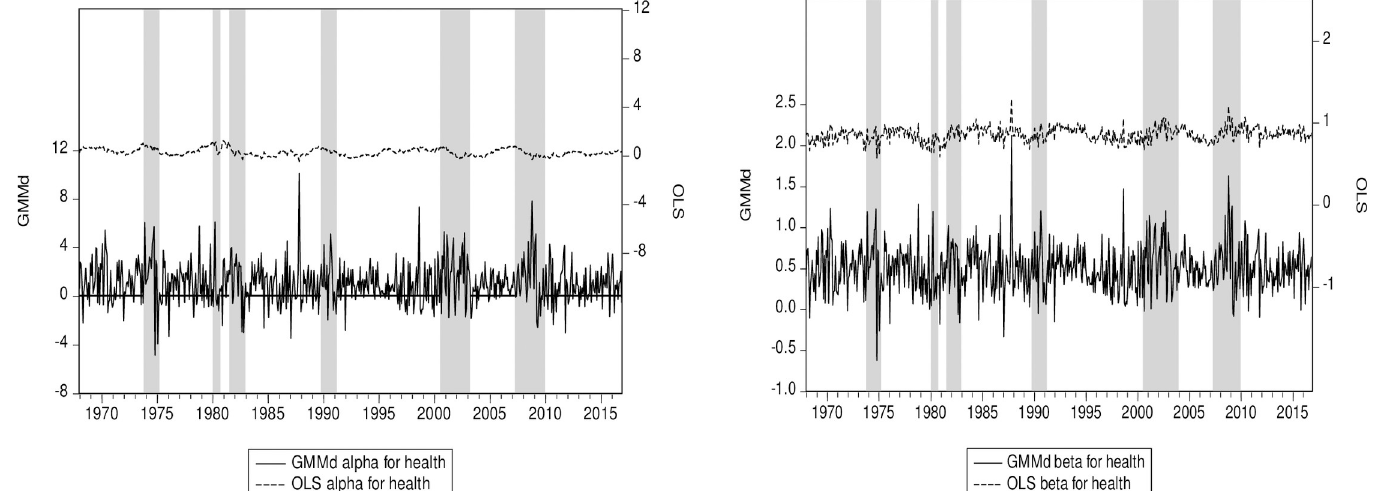
Fig 5. (a) Health alpha for RIV GMM and OLS. (b) Health beta for RIV GMM and OLS. Notes: The health sector has the lowest value of the OLS factor loading for illiquidity IML . RIV GMM (GMMd) is our robust instrumental variables approach. Shaded areas represent US recessions or crises. The OLS and GMM series are plotted on the same scale.